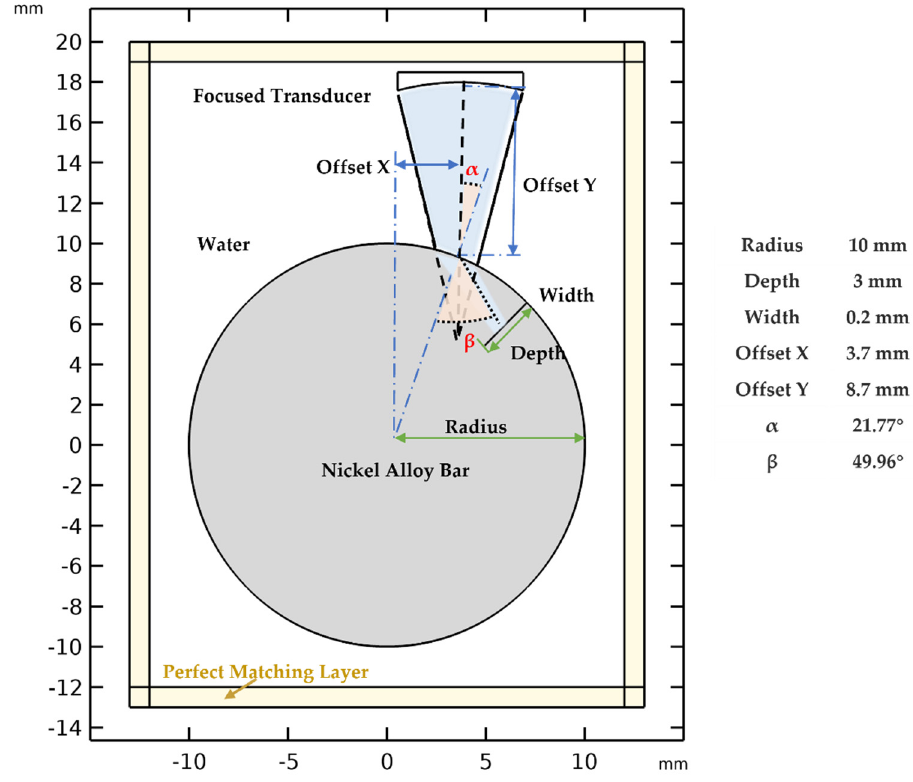
Figure 4. Setup for ultrasonic inspection of nickel - based bars with a mode - converted transverse wave.